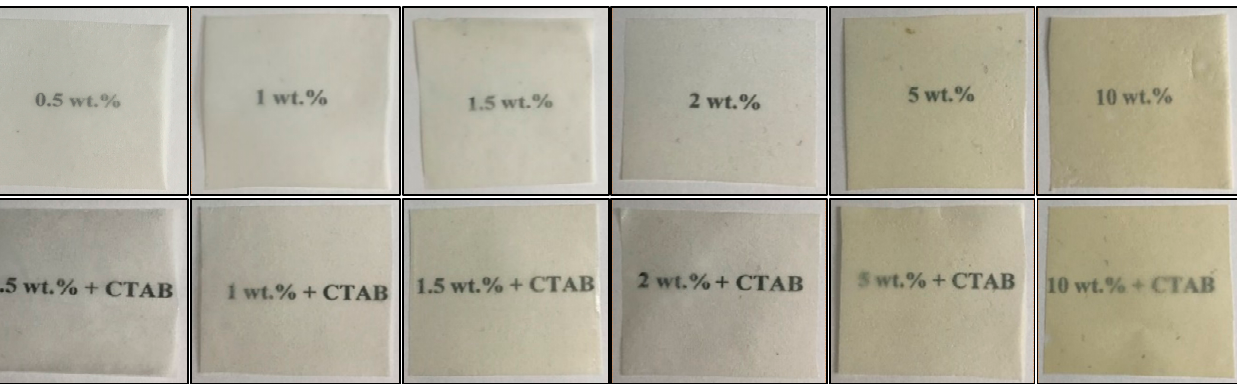
Figure 7. Comparison of the cross-section morphology for the electrospun poly(3-hydroxybutyrate- co-3-hydroxyvalerate) (PHBV) films: ( a ) 0.5 wt.% CeO 2 NPs + CTAB; ( b ) 1.0 wt.% CeO 2 NPs + CTAB; ( c ) 1.5 wt.% CeO 2 NPs + CTAB; ( d ) 2.0 wt.% CeO 2 NPs + CTAB; ( e ) 5.0 wt.% CeO 2 NPs + CTAB; ( f ) 10.0 wt.% CeO 2 NPs + CTAB. Images were taken by scanning electron microscopy (SEM). Scale bar 50 µ m.